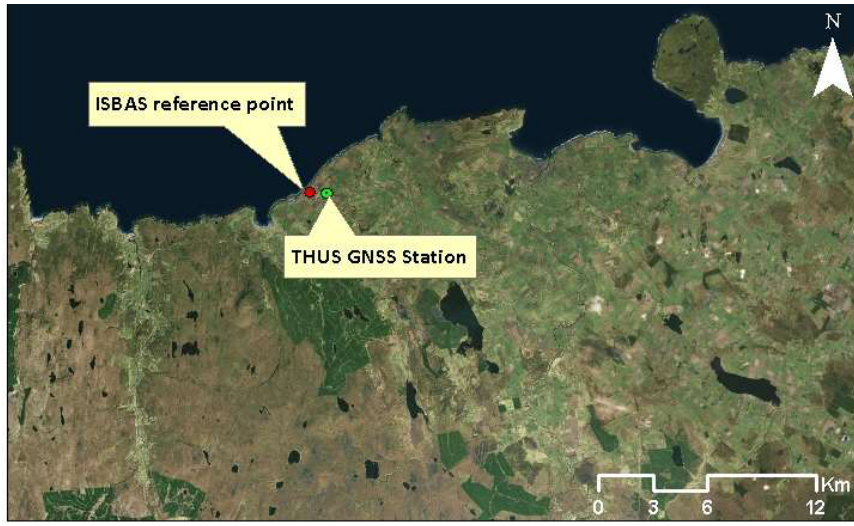
Figure 3. Relative location of ISBAS reference point used and the nearby Thurso (THUS) GNSS station: comparison of the motion data from the two indicates stability of the reference point.